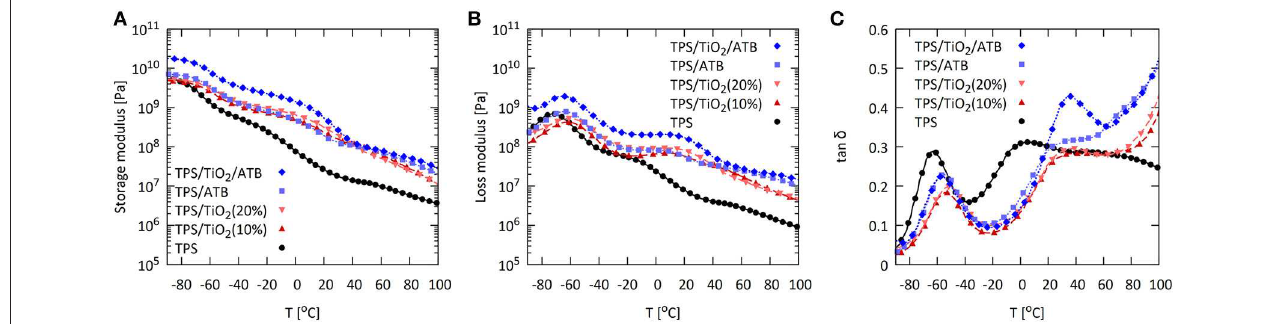
FIGURE 8 | Dynamic mechanical thermal analysis of the TPS/TiO 2 /ATB composites at the angular frequency of 6.28 rad/s and strain of 0.05%: (A) Storage modulus G ′ , (B) loss modulus G ′′ , and (C) damping factor tan( δ